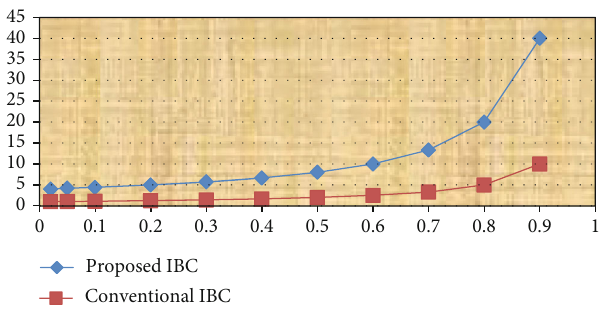
Figure 14: Voltage gain comparison between conventional IBC and proposed